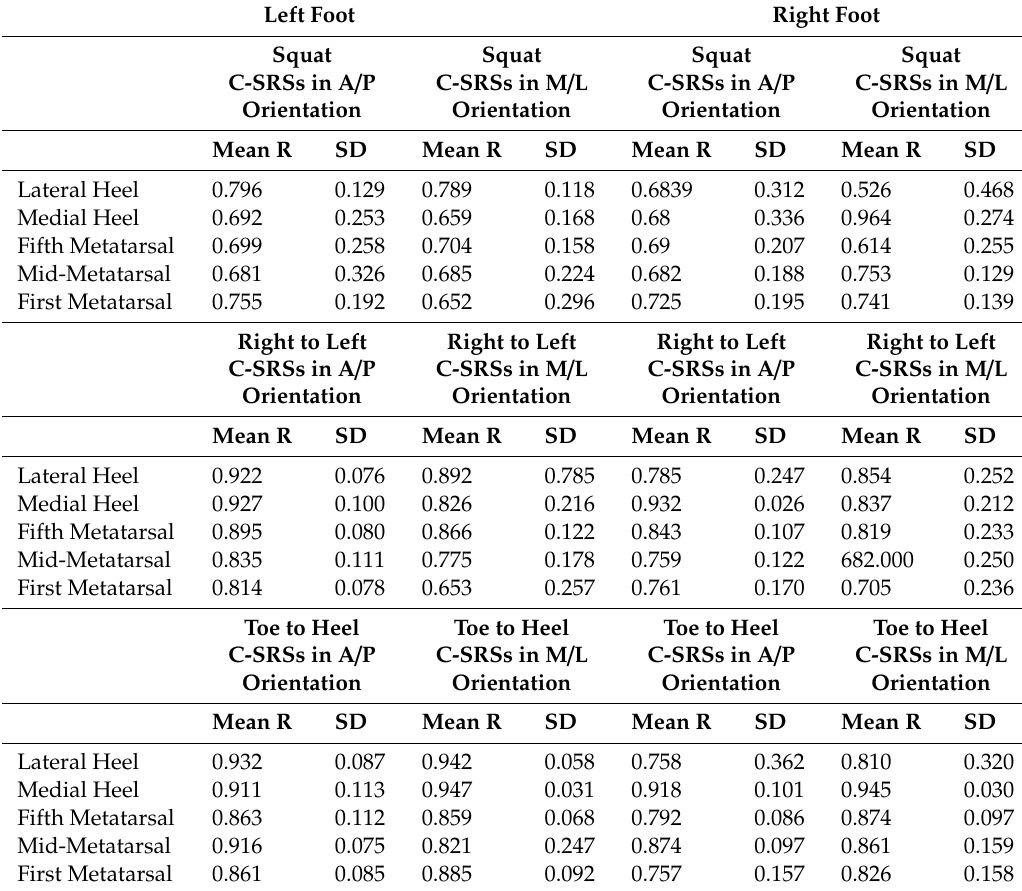
Table 1. Mean and standard deviations of R values from the thirteen participants positional C-SRSs to BodiTrak TM Vector Plate cells.